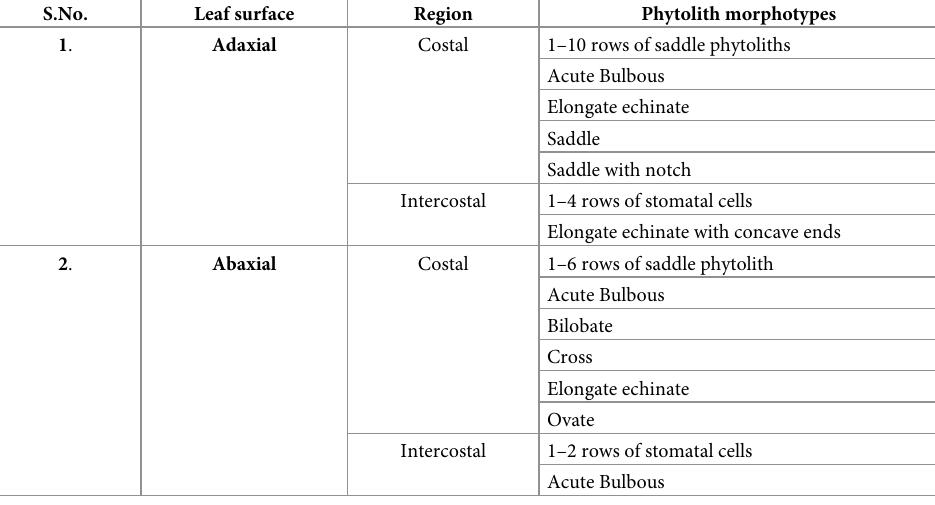
Table 1. Type of phytolith morphotypes in costal and intercostal region of adaxial and abaxial leaf surface of Acrachne racemosa (Heyne ex Roem. & Schult.) Ohwi. S.No.